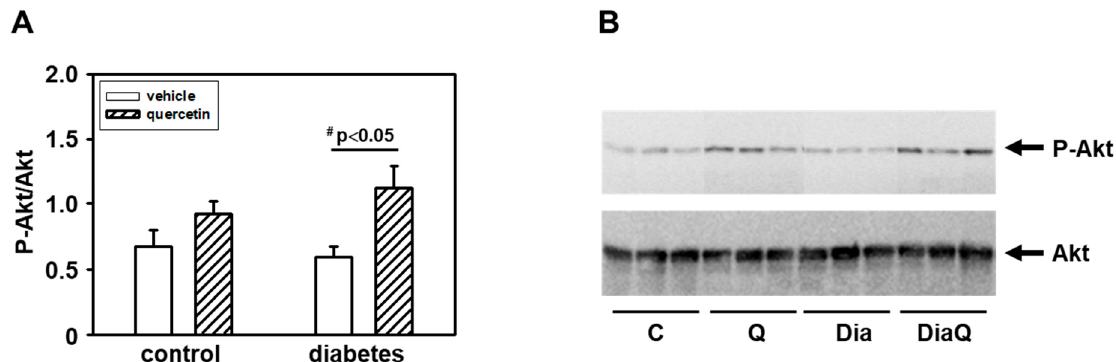
Figure 7. Effects of quercetin treatment on Akt kinase activation in left ventricular tissue of control lean and obese diabetic Zucker Diabetic Fatty (ZDF) rats. ( A ) The quantification of Akt kinase phosphorylation (activation). Data were obtained from Western blot records and are expressed as a ratio of content of serine 473(Ser473) phosphorylated Akt kinase to total Akt kinase. Each bar represents mean ± SEM, n = 6–7. Statistical significance was revealed by Student’s unpaired t -test, # p < 0.05 vs. obese diabetic vehicle-treated rats. ( B ) Western blot records showing the changes in protein levels and specific phosphorylation of Akt kinase. The changes in activation of Akt kinase were determined using an antibody which reacts with Akt kinase phosphorylated specifically on Ser473. C—control lean vehicle-treated ZDF rats; Q—lean quercetin-treated ZDF rats; Dia—obese diabetic vehicle-treated ZDF rats; DiaQ—obese diabetic quercetin-treated ZDF rats.